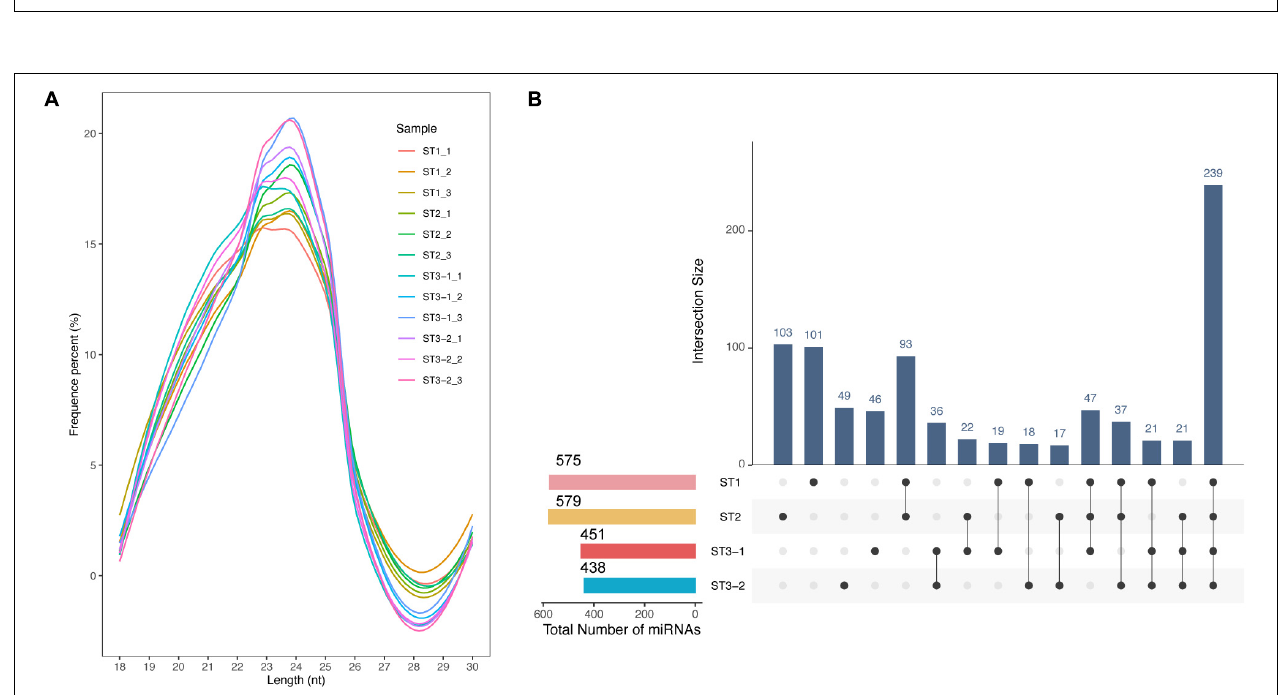
FIGURE 4 | The lncRNA-mRNA co-expression networks during the initiation and enlargement of ovulate stalk primordia in ginkgo. (A) The lncRNA-mRNA co-expression network trans -regulated by differentially expressed lncRNAs (DElncRNAs) between the initial differentiation (ST2) and the early exuberant differentiation stages (ST3-1). (B) The lncRNA-mRNA co-expression network trans -regulated by DElncRNAs between the early (ST3-1) and the late (ST3-2) exuberant differentiation stages.